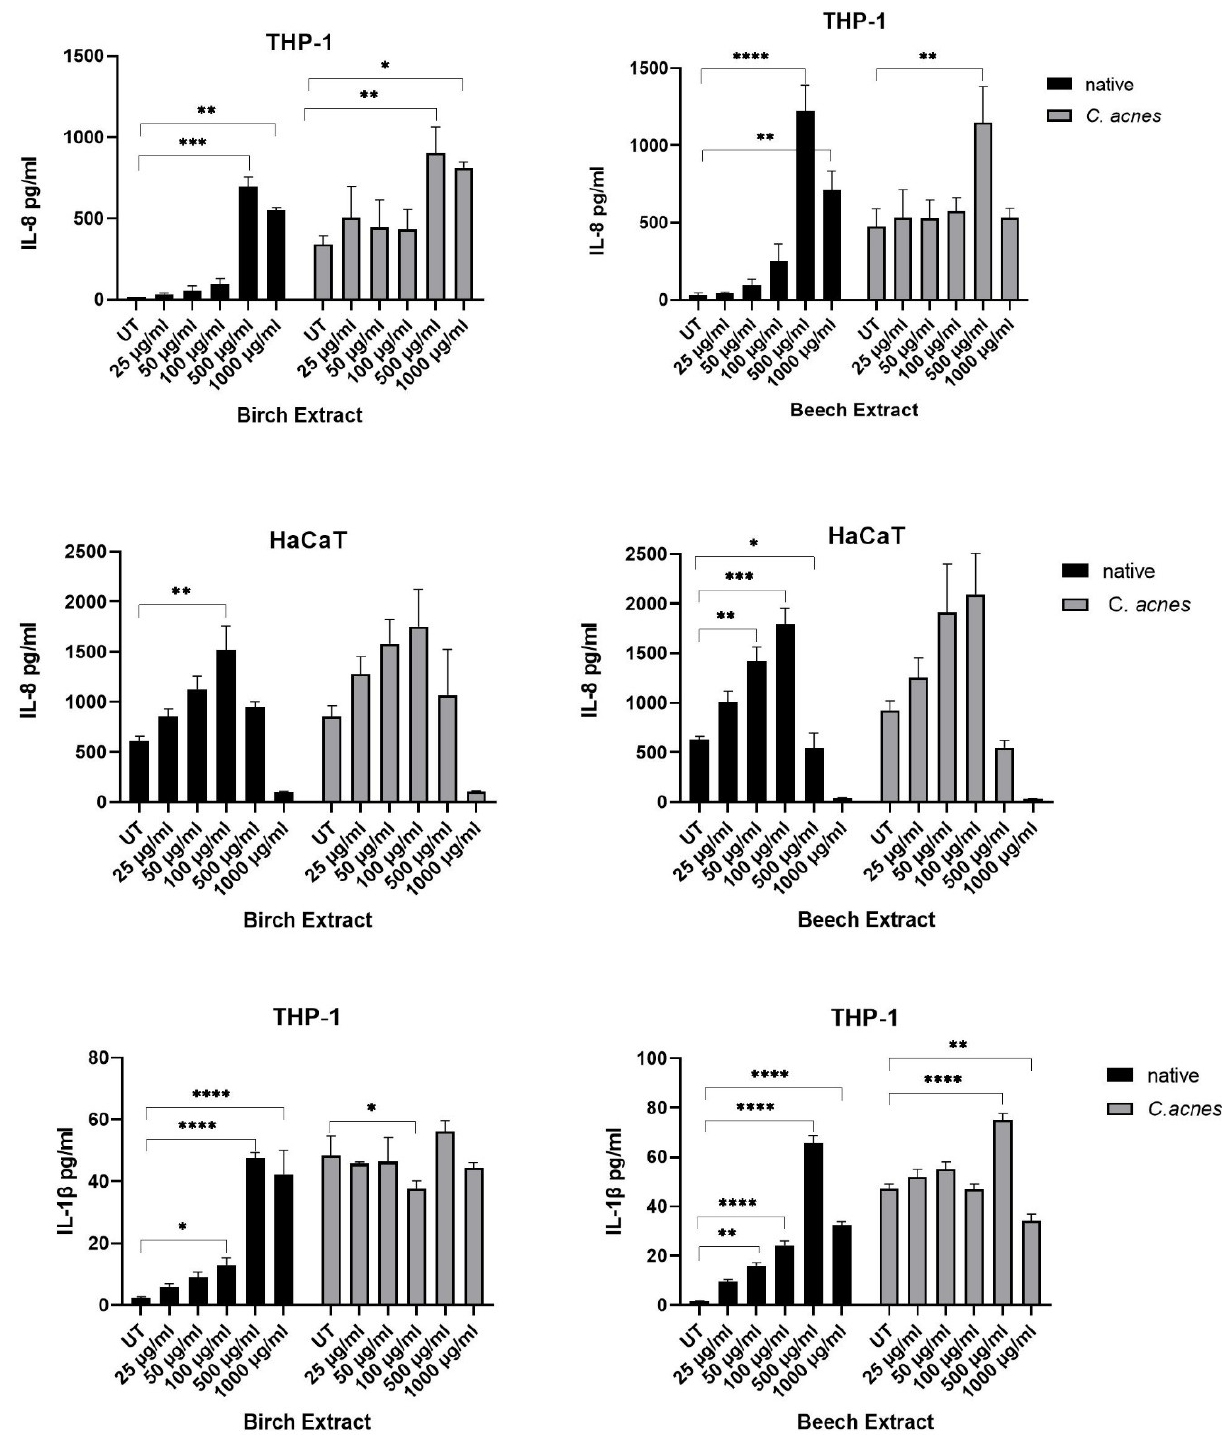
Figure 4. Pro-inflammatory cytokine expression (IL-8 and IL1beta) in THP-1 and HaCaT cell super- natants after 24 h incubation with extracts. Columns present means of triplicates ( n = 3); the error bars show SD. * p < 0.05, ** p < 0.01, *** p < 0.001, **** p < 0.0001